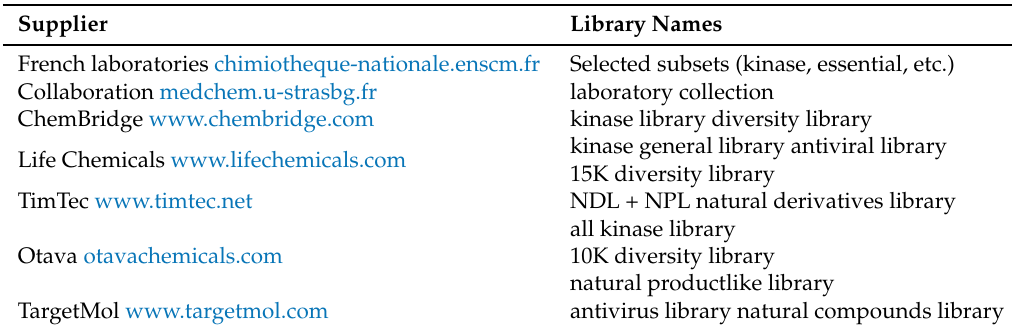
Table 1. List of the selected chemical libraries used in the present virtual screening campaign, providing a total of 76,251